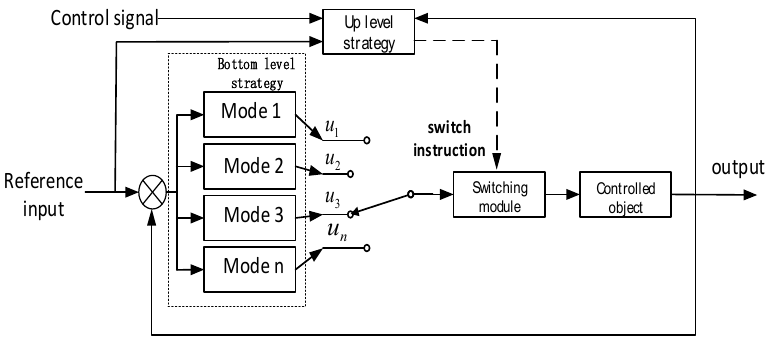
Figure 4. Bumpless mode switching control structure.